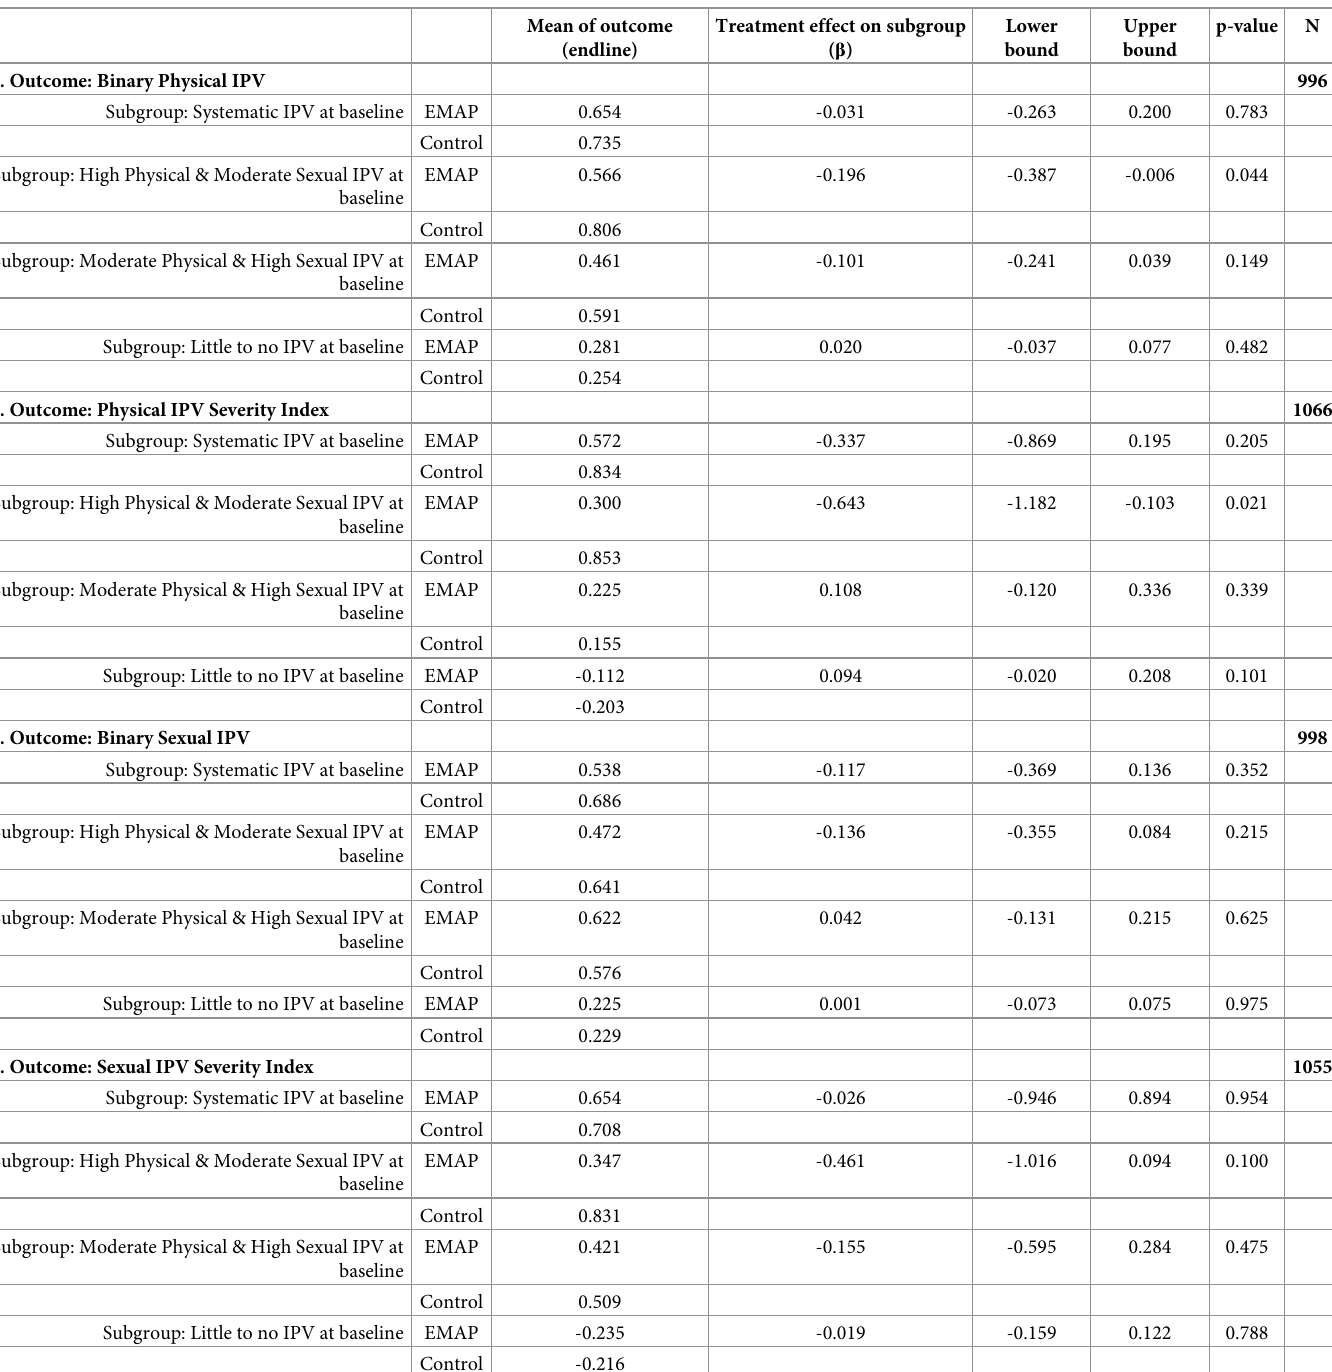
Table 6. Effects of EMAP on experience of IPV by latent subgroups at